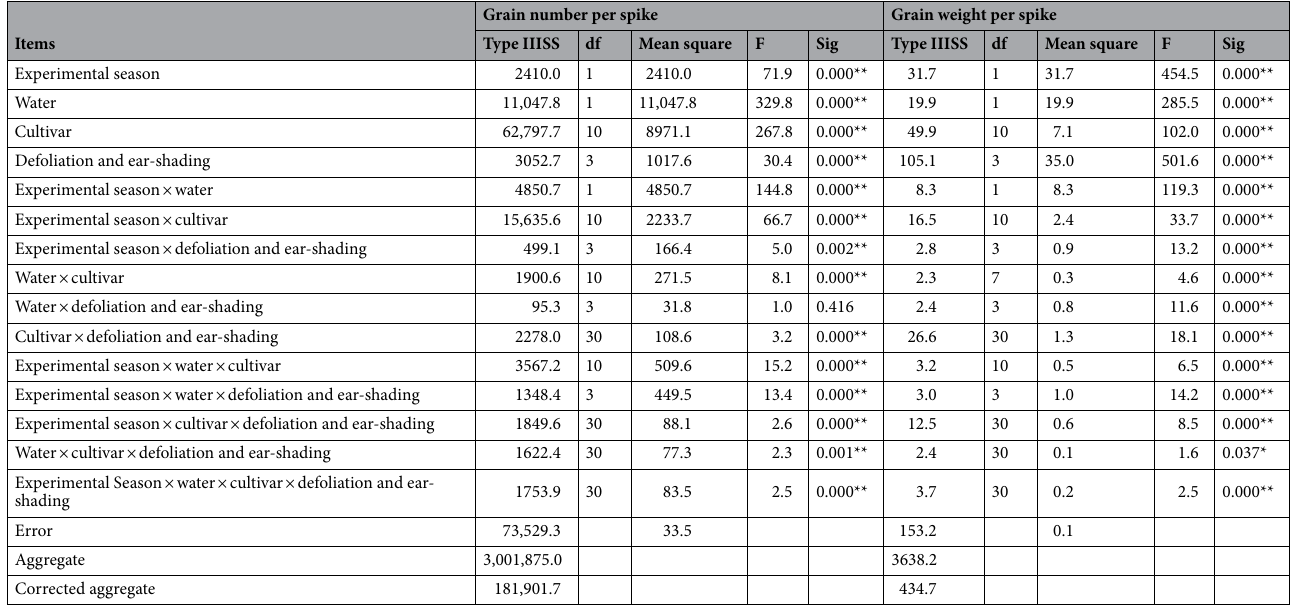
Table 4. Contribution of different factors to grain number and grain weight per spike. *Significant at P < 0.05; **significant at P <